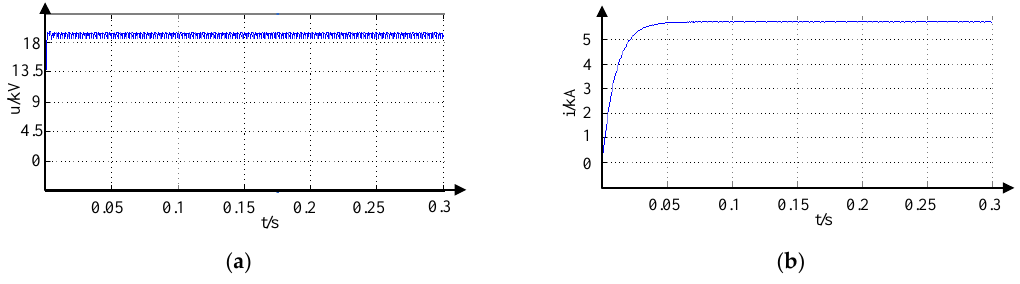
Figure 9. The output waveforms of DC ice-melting: ( a ) voltage; ( b ) current.